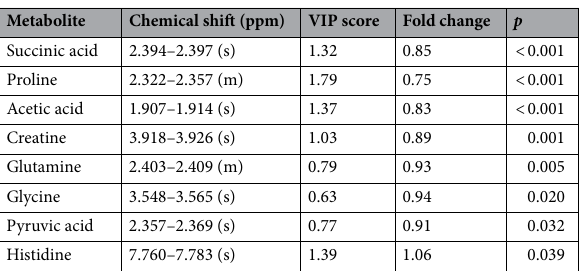
Table 2. Significantly differentially-expressed metabolites between the MDD patients with full remission and the healthy controls. MDD major depressive disorder, VIP variable importance in the projection, s singlet, m multiplet.